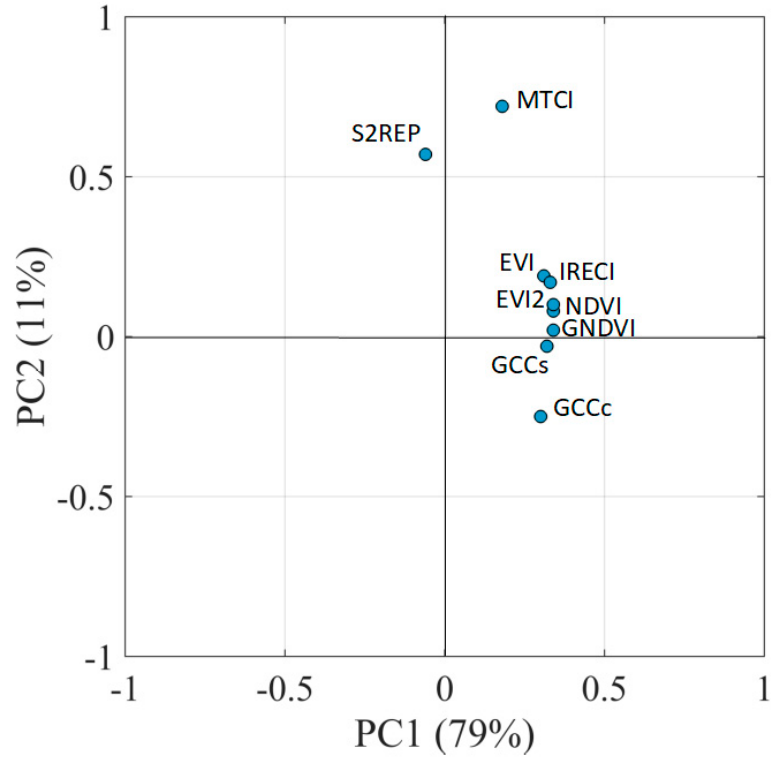
Figure 5. Principal component analysis (PCA) of GCCc and vegetation indices. The two first principal components (PCs) are shown. Between parenthesis: percentage of variance